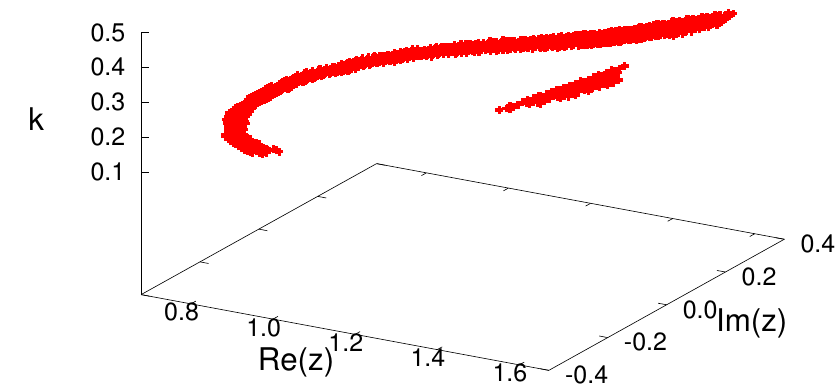
Figure 1 . The vertical axis represents the parameter k and the horizontal plane represents the parameter z . Im( z ) indicates the breaking of (cid:22) - (cid:28) -re(cid:13)ection symmetry. The plot is not symmetric about the Re( z ) axis because the deviation of the experimental data from (cid:22) - (cid:28) -re(cid:13)ection symmetry is skewed towards a higher value for sin 2 (cid:18) 23 away from 0 : 5, i.e. sin 2 (cid:18) 23 = 0 : 428 $ 0 : 624.